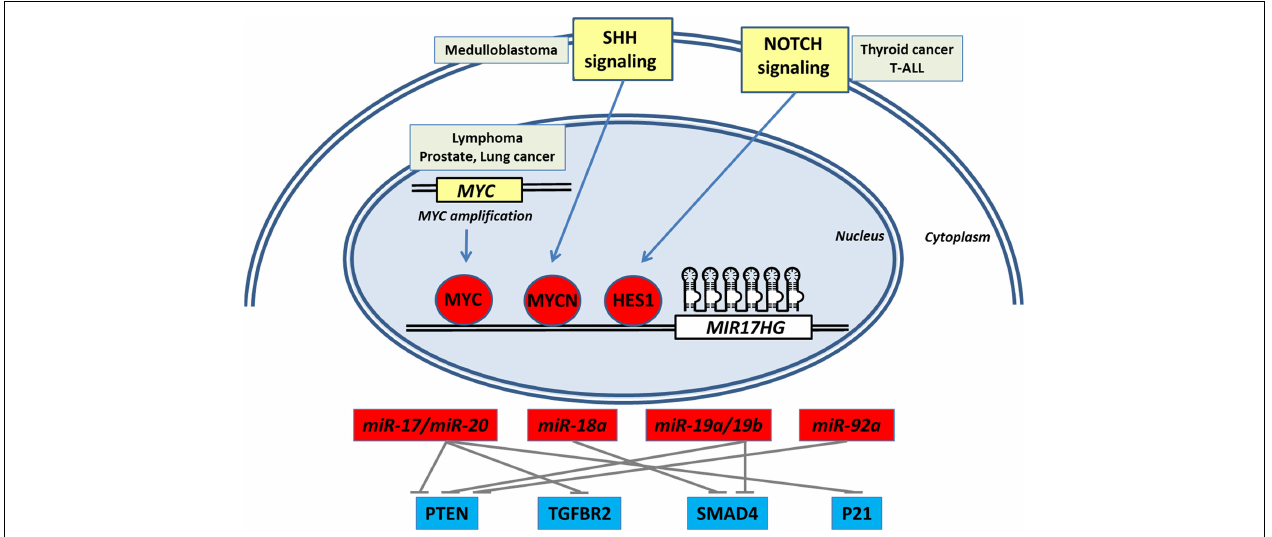
FIGURE 1 | Coordinated transcriptional activation of miR-17-92 by oncogenic signaling pathways synergistically down-regulates important negative regulators of cell growth and proliferation signaling in cancer .